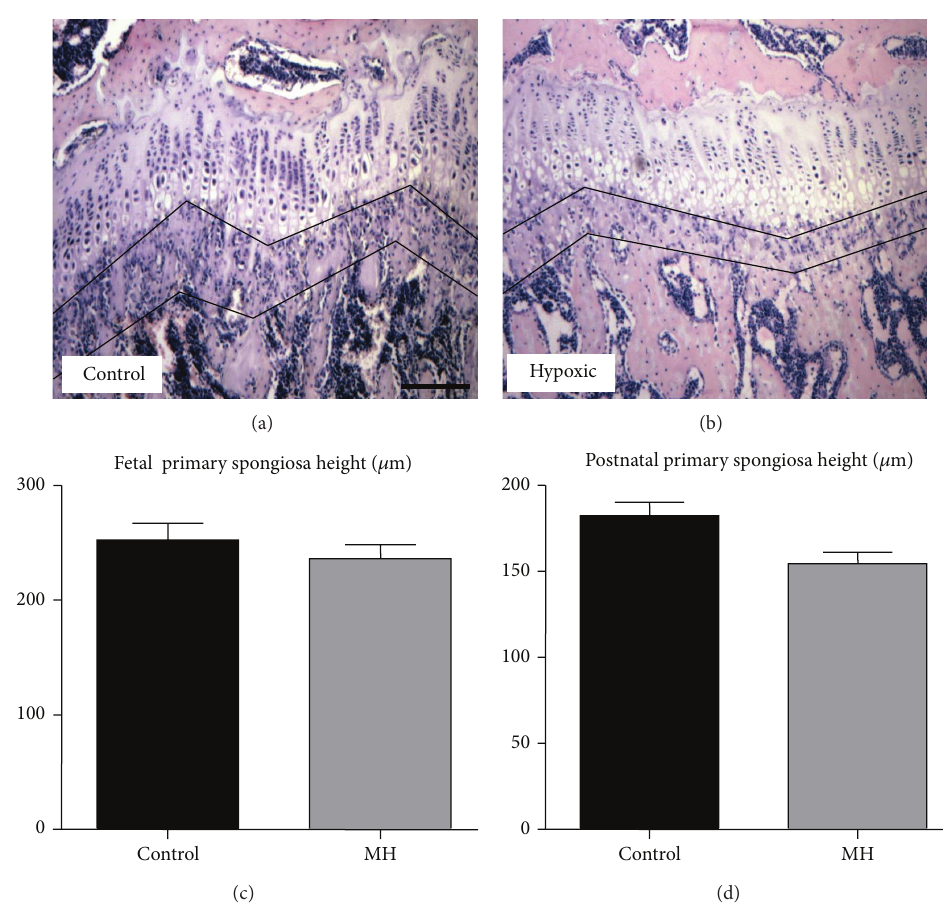
Figure 3: Effects of maternal hypoxia on offspring proximal tibia primary spongiosa height. (a) and (b) H&E-stained tibial sections (primary spongiosa shown between two tracing lines) of 120d postnatal guinea pigs from a control and a hypoxic mother, respectively. (c) Primary spongiosa height of (c) 62d gestation fetal and (d) postnatal 120d guinea pigs from control and hypoxia-treated mothers ( 𝑛 = 5 ). Scale bar in (a) = 1mm and applies to